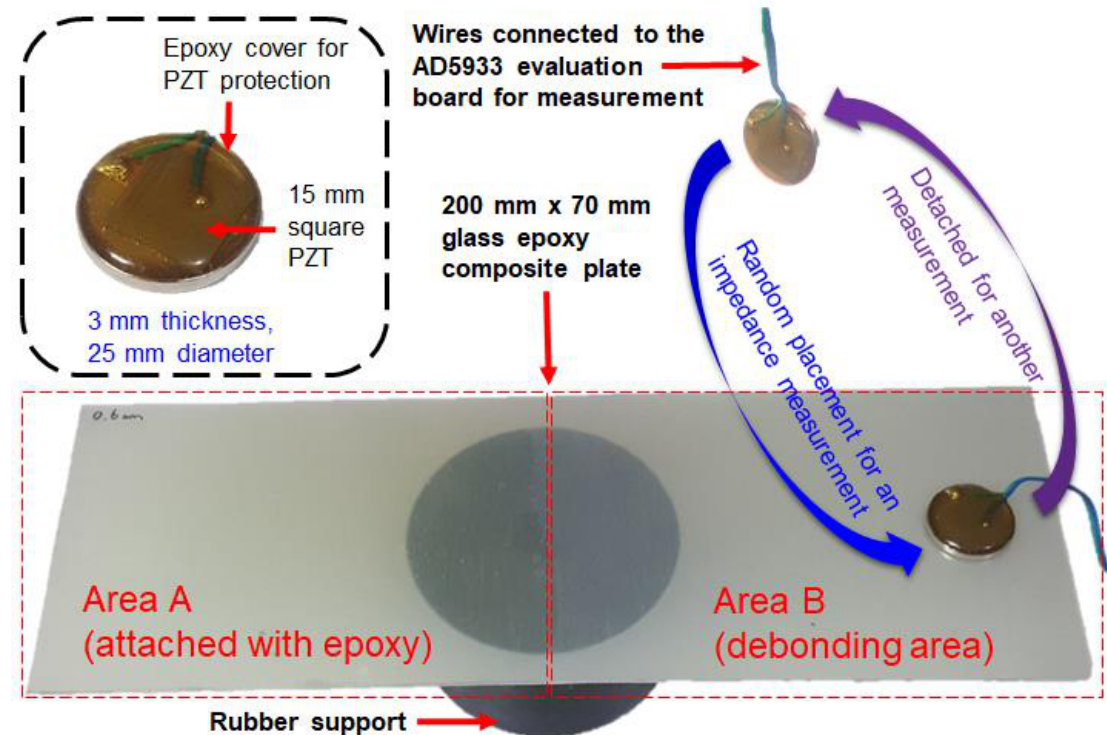
Figure 2. Experiment concept with the piezoelectric (PZT)-metal transducer (c.f. [23]).